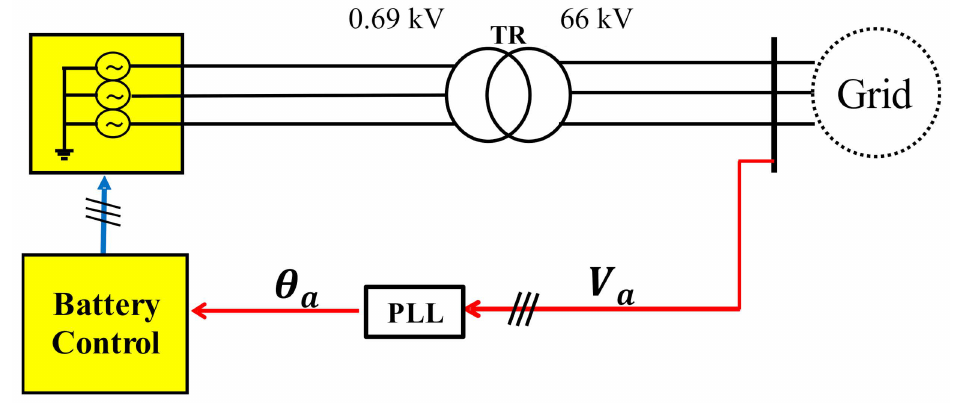
Figure 10. Simple battery model.